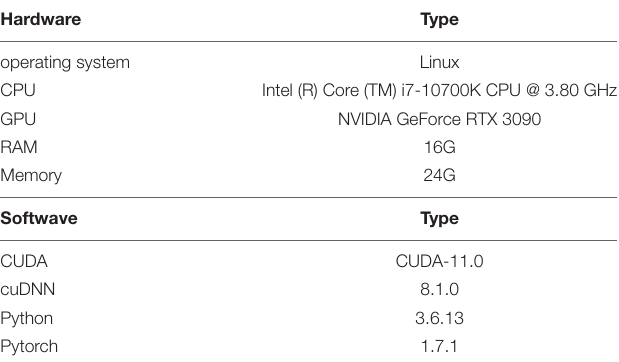
TABLE 2 | Portunus trituberculatus ReID experiment platform.